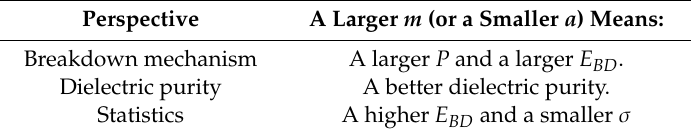
Table 4. Information betrayed from m when m ≥ 4 for thick dielectrics (or information betrayed from a when a ≤